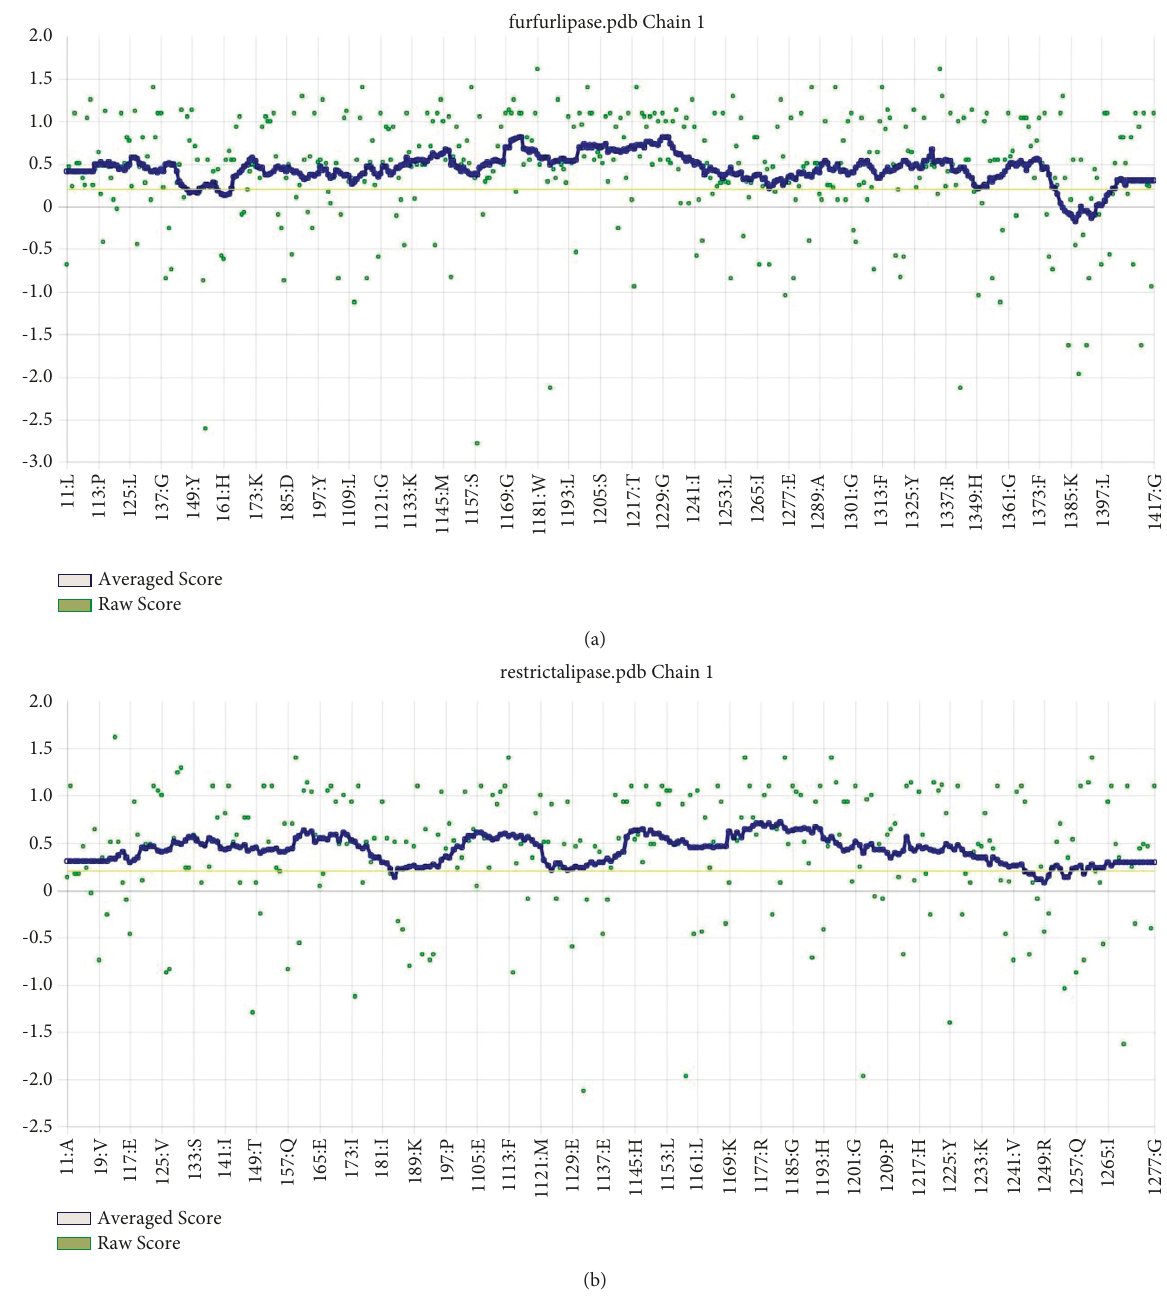
Figure 3: Verify 3D plot for Lipase of (a) Malassezia furfur and (b) Malassezia restricta